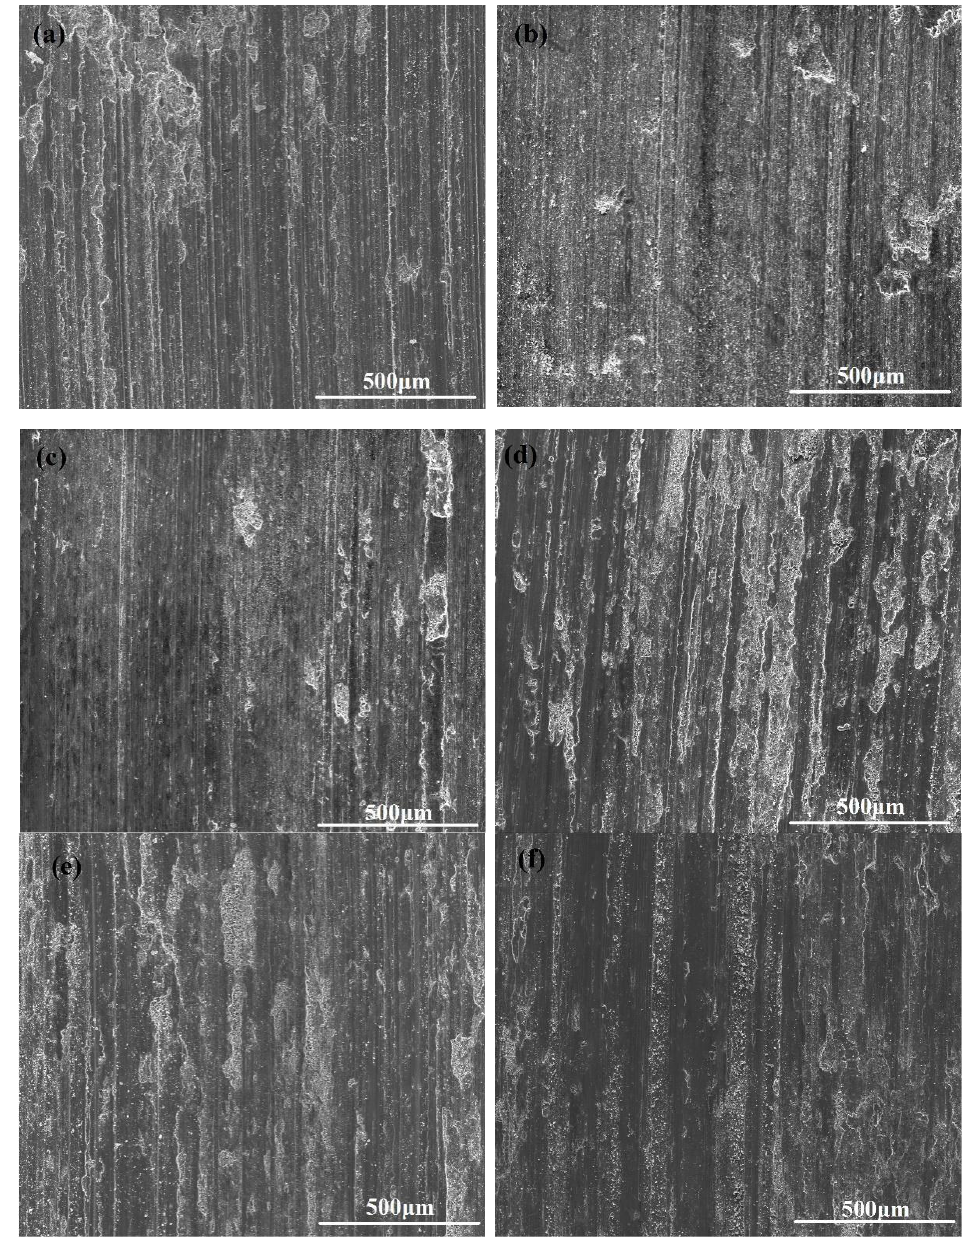
Figure 21. Wear morphology of rheoformed 2024 aluminum matrix composite component reinforced by Al 2 O 3 nanoparticles with different volume fraction at 620 °C for 25 min stirring time ( a ) 0; ( b ) 1%; ( c ) 3%; ( d ) 5%; ( e ) 7%; ( f ) 10%.